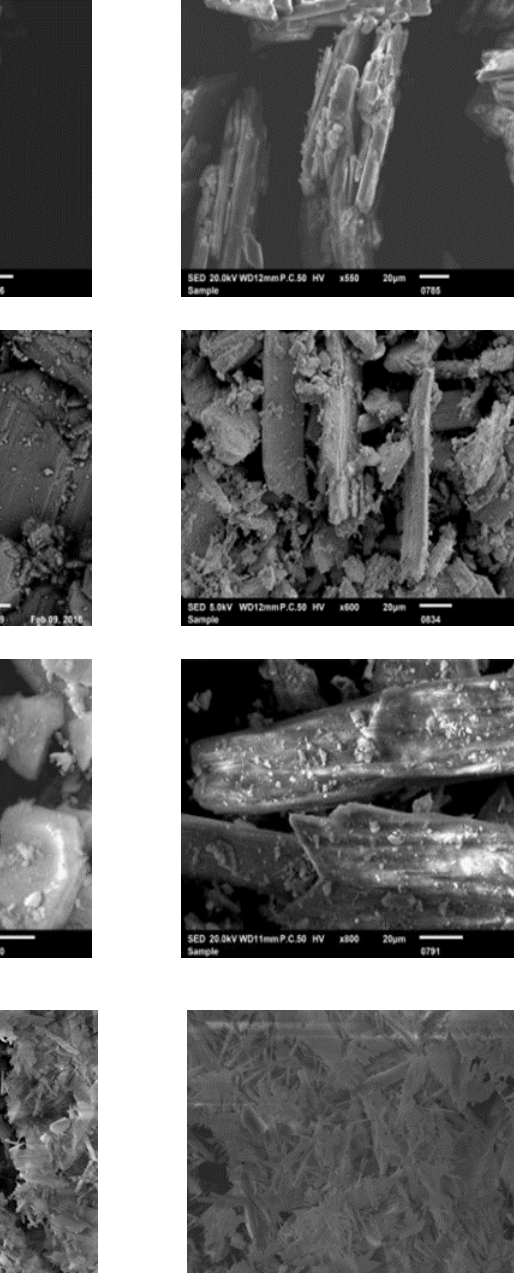
Table 4. Textural properties of the PGM and PGT samples.